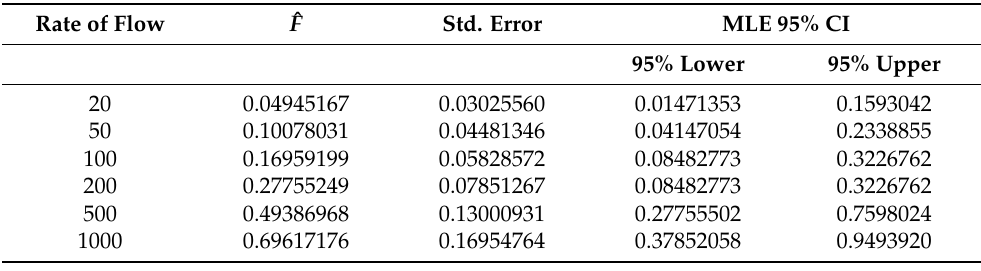
Table 1. Failure rate calculated based on different stages of rate of flow for pilot plot data.